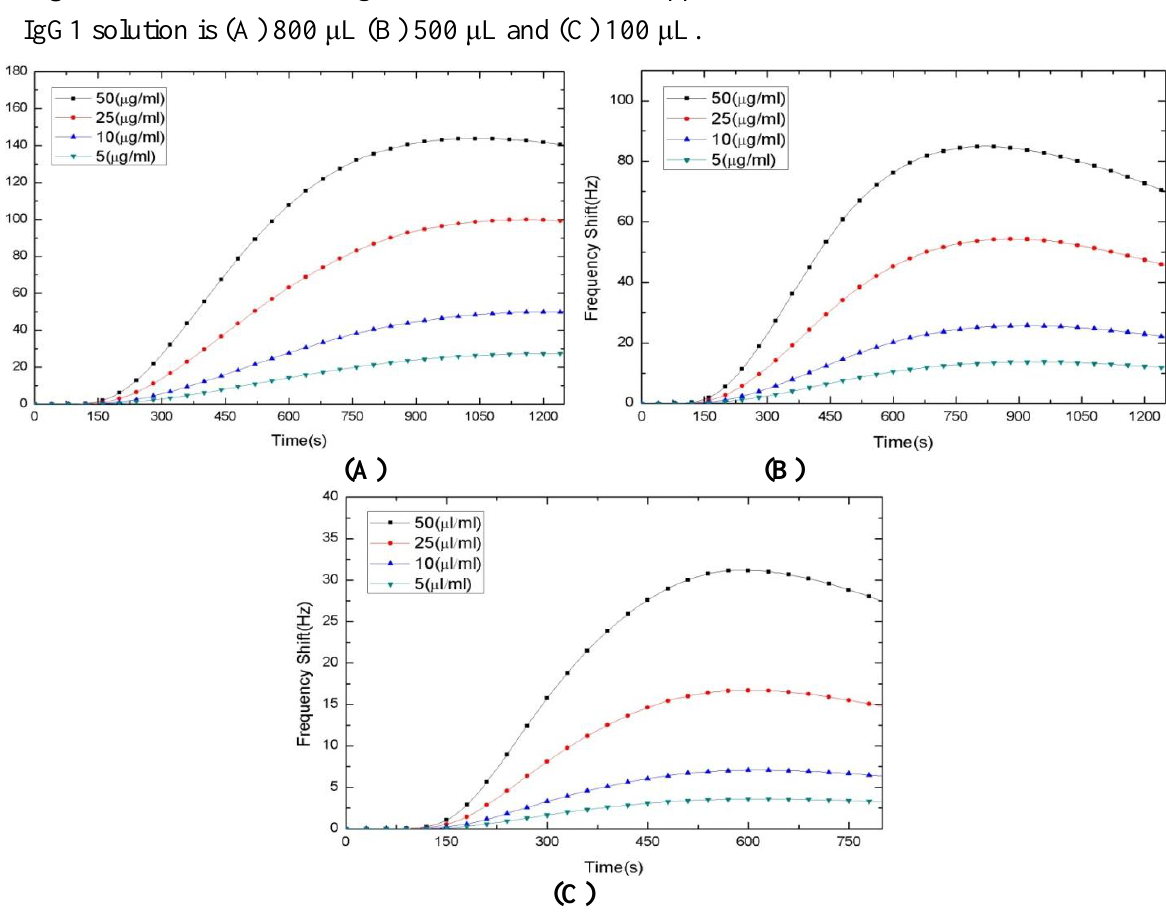
Figure 4. Simulated binding reaction curves. The supplement volume of the